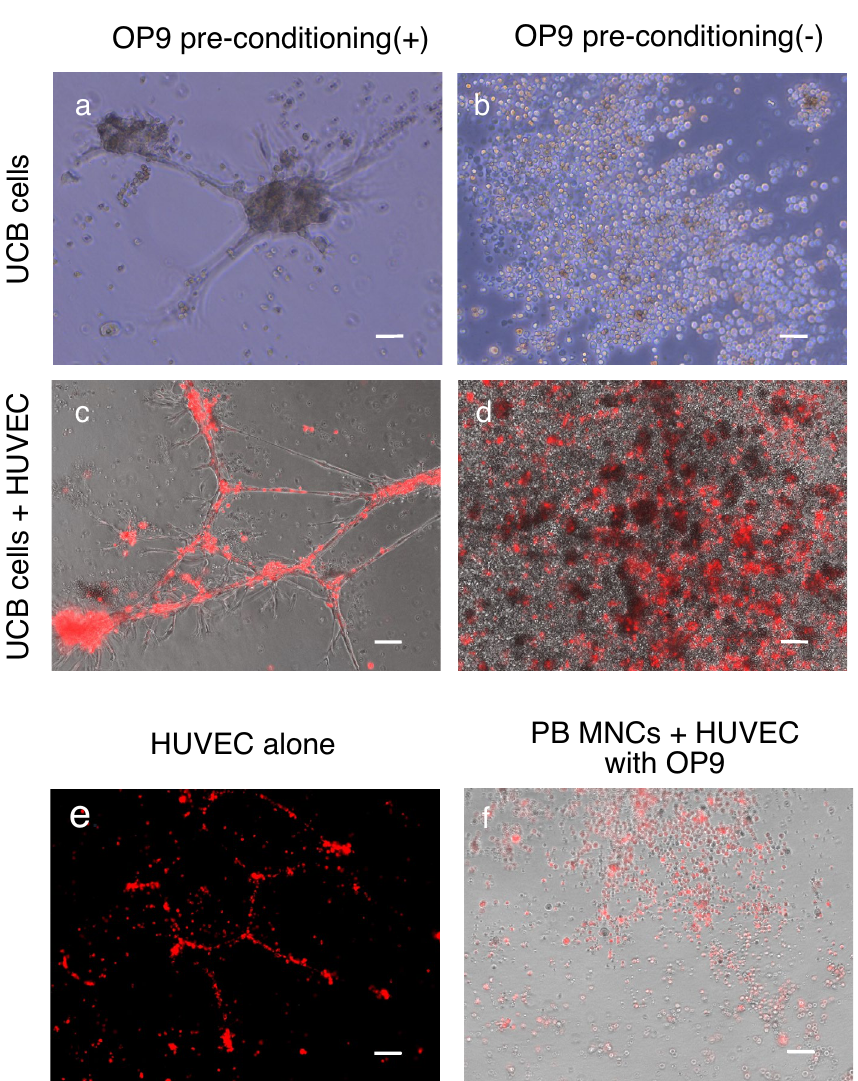
Figure 2. In vitro network formation assay using UCB- or PB-MNC-derived adherent cells with or without OP9 pre-conditioning. The panel names of ( a – f ) are identical to those of ( a – f ) in Fig. 1a. UCB- or PB-MNC- derived adherent cells with or without OP9 pre-conditioning were seeded onto Matrigel. Human umbilical vein endothelial cells (HUVECs) were added in panels ( c )–( f ). ( a ) OP9-pre-conditioned UCB cells showing capillary-like structures. ( b ) UCB cells without OP9 pre-conditioning. ( c ) OP9-pre-conditioned UCB cells with HUVECs. ( d ) HUVECs and UCB cells without OP9 pre-conditioning. ( e ) HUVECs alone